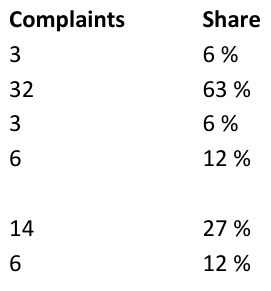
Figure 8: Assessment of biodiversity losses by people of different age groups and recreation patterns (younger people = up to 40 years) Table 3: Reasons of tourism service providers (TSP) for refusing payment for nature